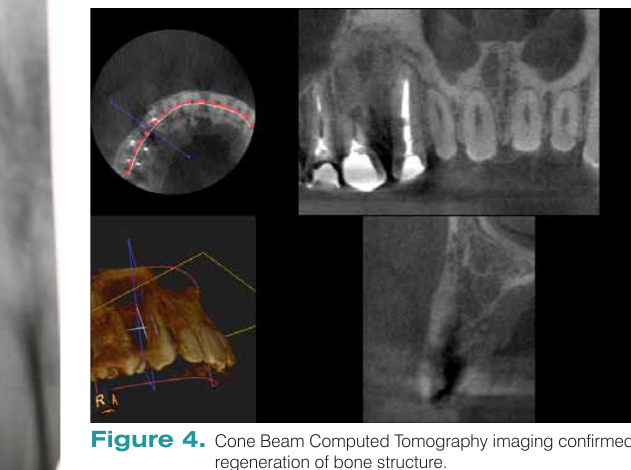
Figure 4. Cone Beam Computed Tomography imaging confirmed regeneration of bone structure. a. cross-section in a horizontal plane b. pseudopantomogram